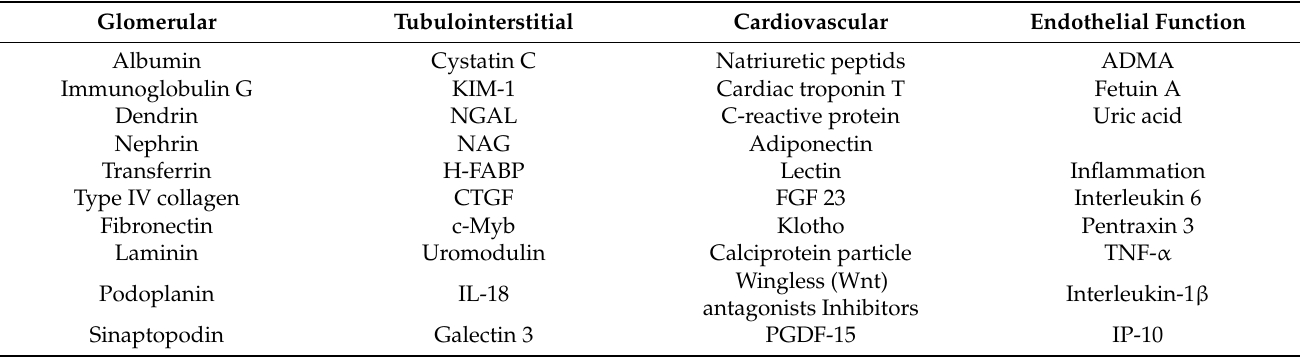
Table 1. Summary of possible biomarkers of chronic kidney disease according to their roles